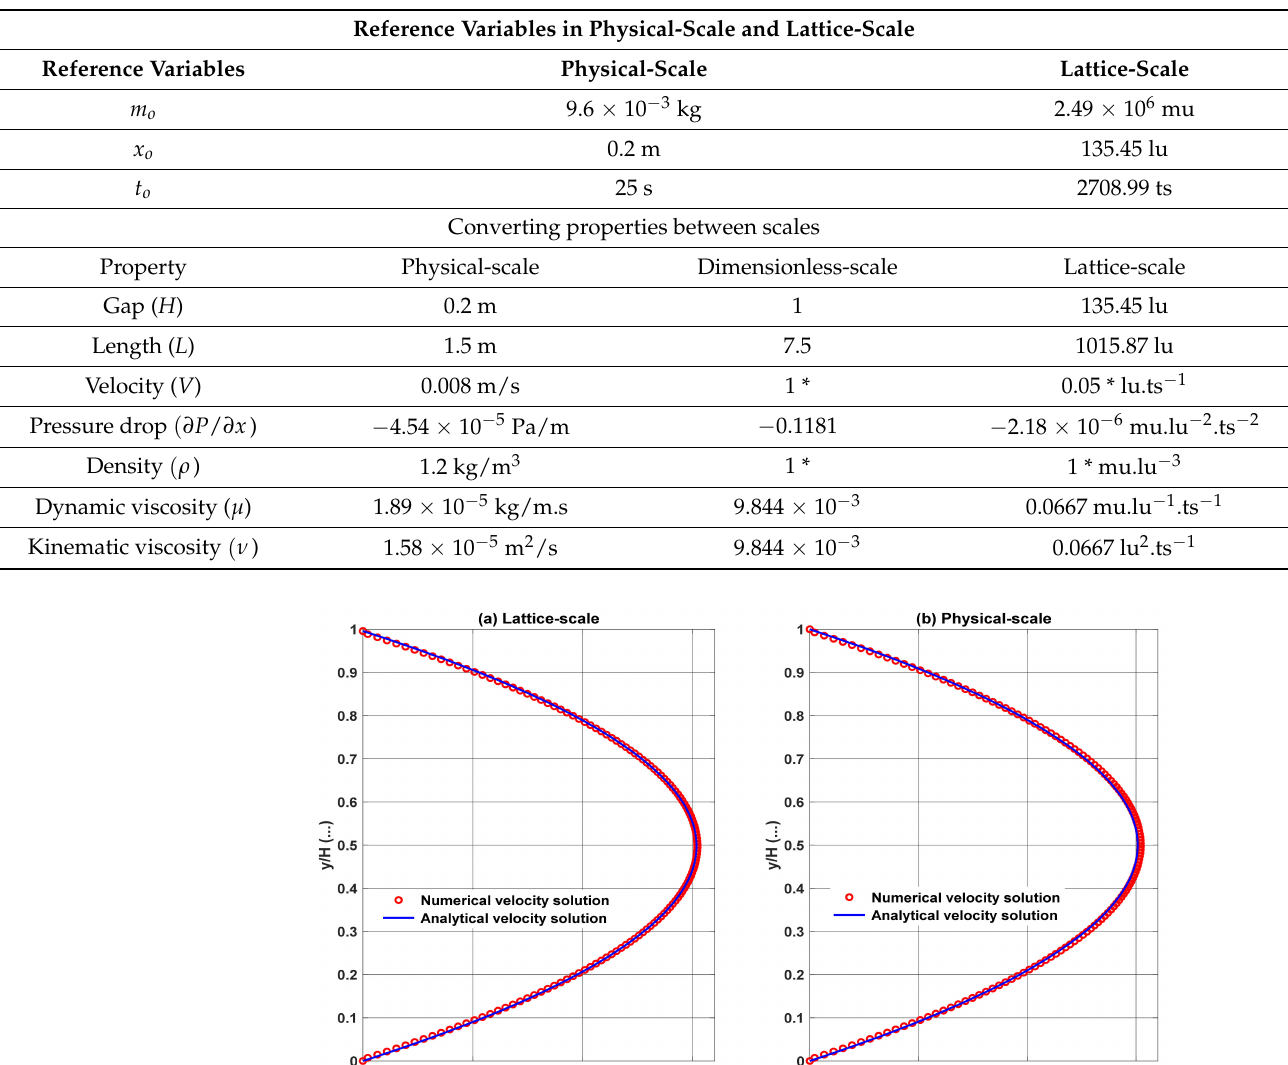
Table 7. Converting data for flow in a channel problem. The values with * represent assumed values.